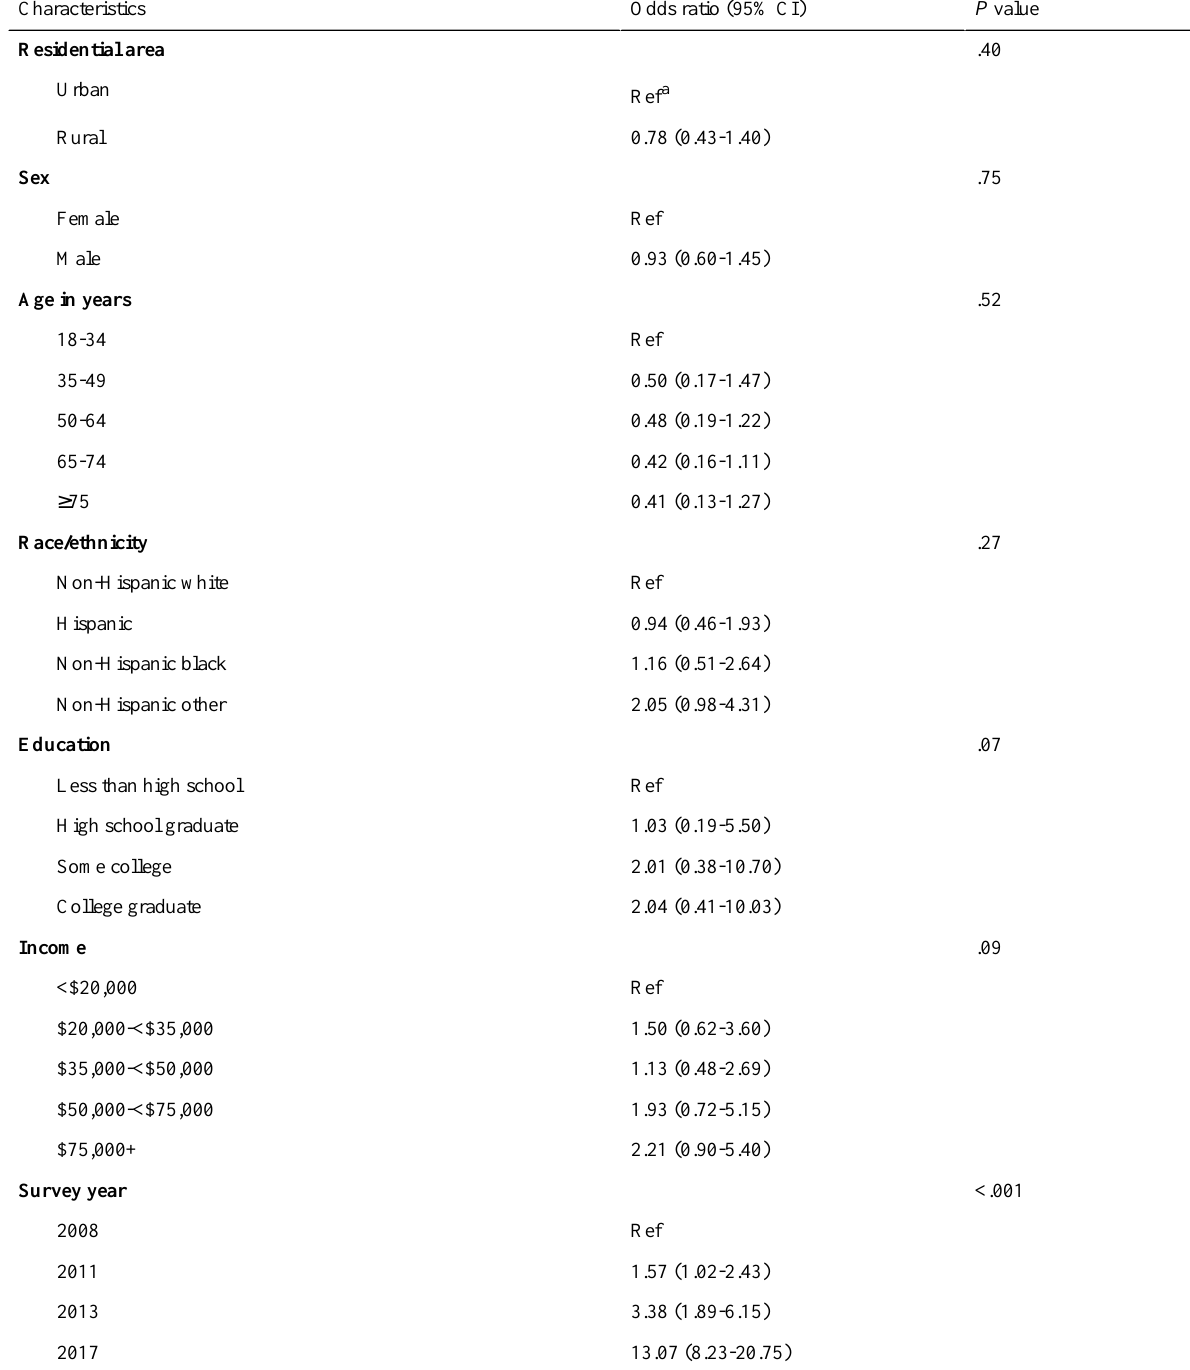
Table 2. Logistic regression model of electronic personal health information use among patients who reported being diagnosed with cancer grouped by rural and urban status based from the Health Information National Trends Survey (n=1388) in the years 2008, 2011, 2013, and 2017, adjusted for sex, age, race/ethnicity, education, and